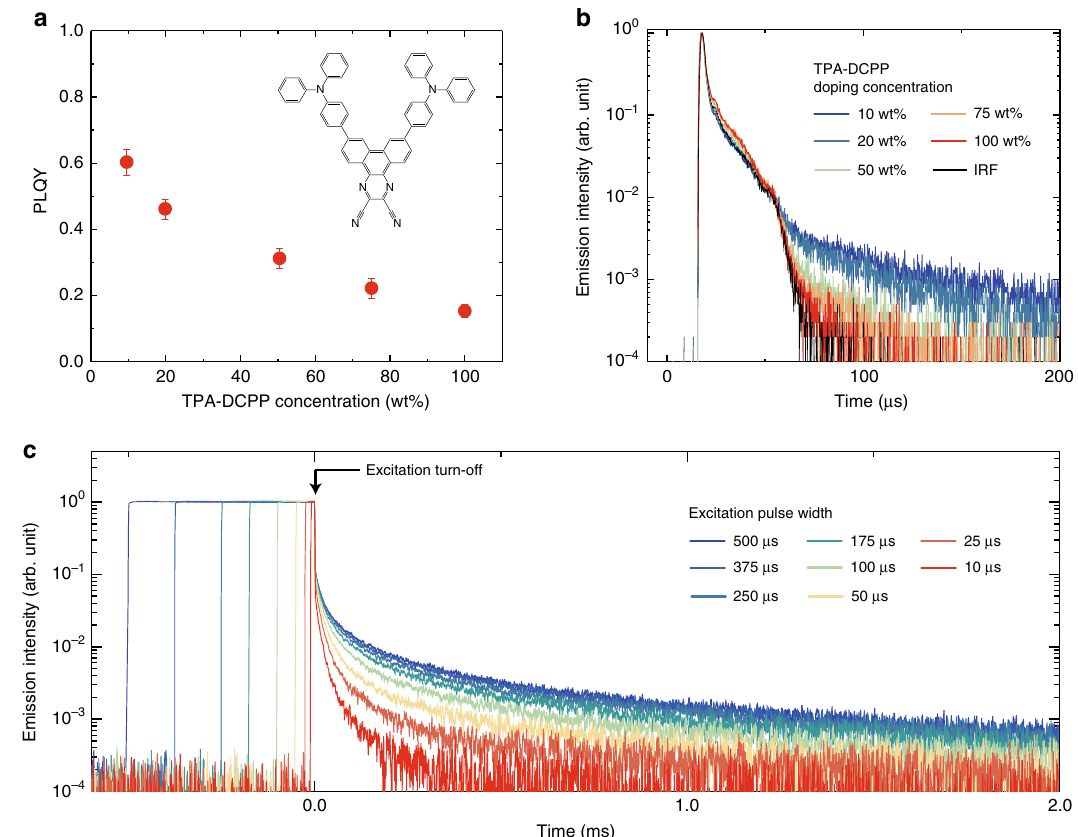
Fig. 1 Fundamental PL properties of TPA-DCPP-based solid-state fi lms. a Concentration dependence of PLQY in TPA-DCPP:CBP blends. The error bars are estimated by taking into account of instrument accuracy and experimental variability. Inset: chemical structure of TPA-DCPP. b TRPL pro fi les in TPA- DCPP:CBP blends with different TPA-DCPP doping concentration. The black line indicates the instrument response function (IRF) of the fl uorescence lifetime spectrometer used for the measurements. c Dependence of TRPL pro fi le on excitation pulse width for a 50-wt%-TPA-DCPP:CBP blend. A 470-nm light source was used as excitation light, and the power density was fi xed at 25 mW cm − 2 . The lifetime of the long-tailed component saturated for pulses longer than width of 375 µ